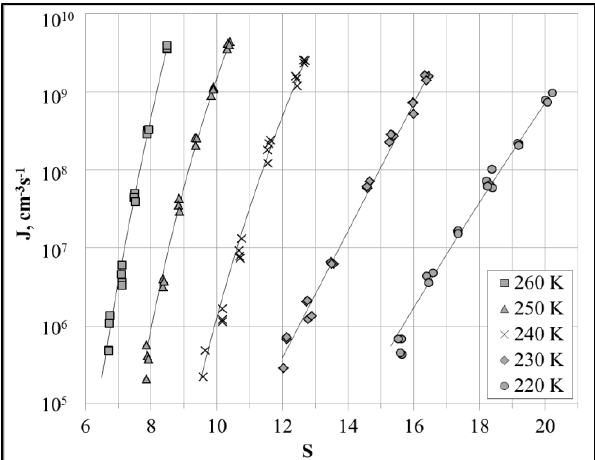
Fig. 4 . Experimental data of water homogenous nucleation with argon as carrier gas.